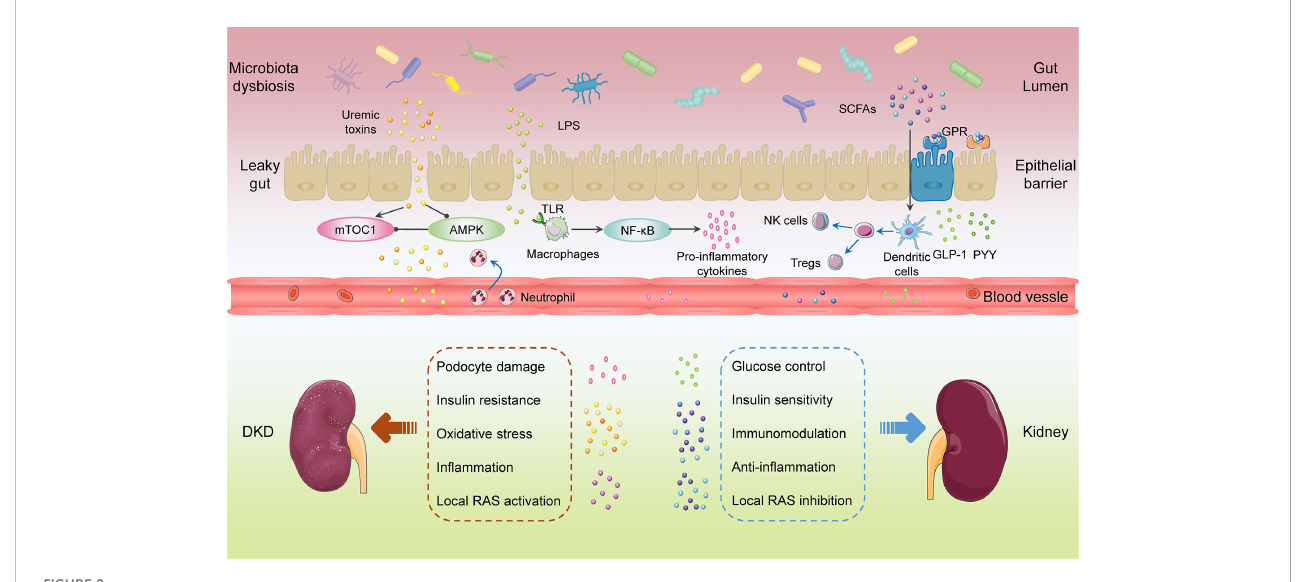
FIGURE 2 Gut microbiota-related factors in the progression of diabetic kidney